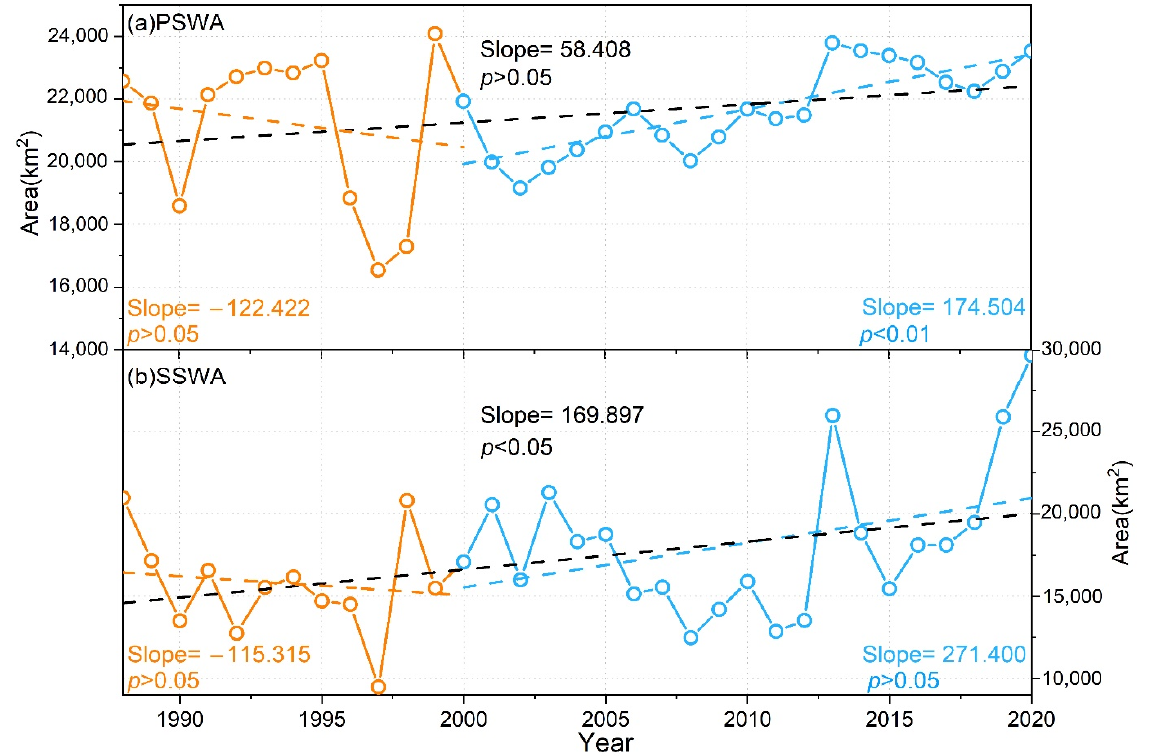
Figure 2. The changing trend of SWA. Due to the differences in data quality, using 2000 as the time node, the trend and significance of SSWA and PSWA in the three-time periods of 1988–1999, 2000– 2020, and 1988–2020 were calculated, respectively. ( a ) PSWA, and ( b ) SSWA.